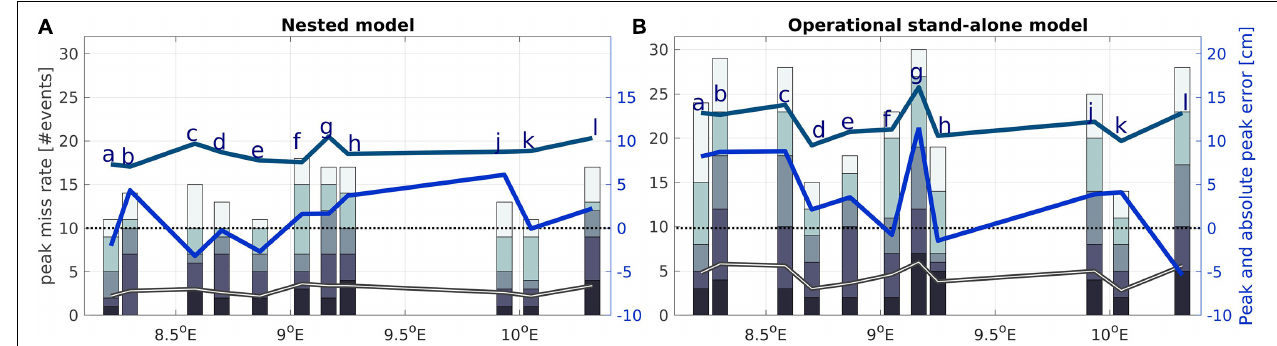
FIGURE 4 | Peak-error comparison of nested model set-up (A) and operational stand alone set-up (B) . Peak error (light blue), absolute peak error (dark blue) of single tolerance assessments and sum of missed peak events (grey) 2015–2019: annual values (bar diagram) and mean value (line), for sea level stations, from west-to-east: (a) Thyboron, (b) Lemvig, (c) Struer, (d) Thisted, (e) Nykøbing Mors, (f) Skive, (g) Rønbjerg Huse, (h) Logstør, (j) Aalborg East, (k) Grønlandshavn and (l)